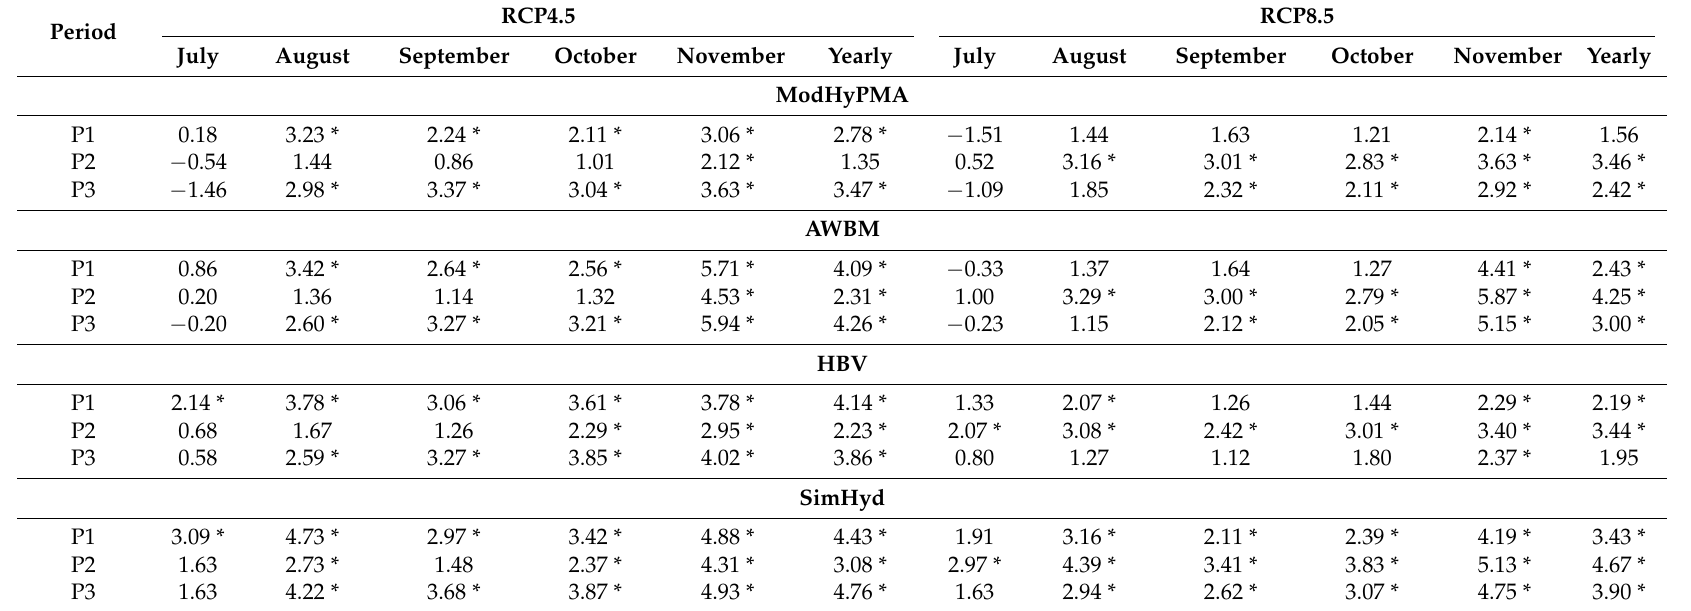
Table 7. Results of student’s t-test for